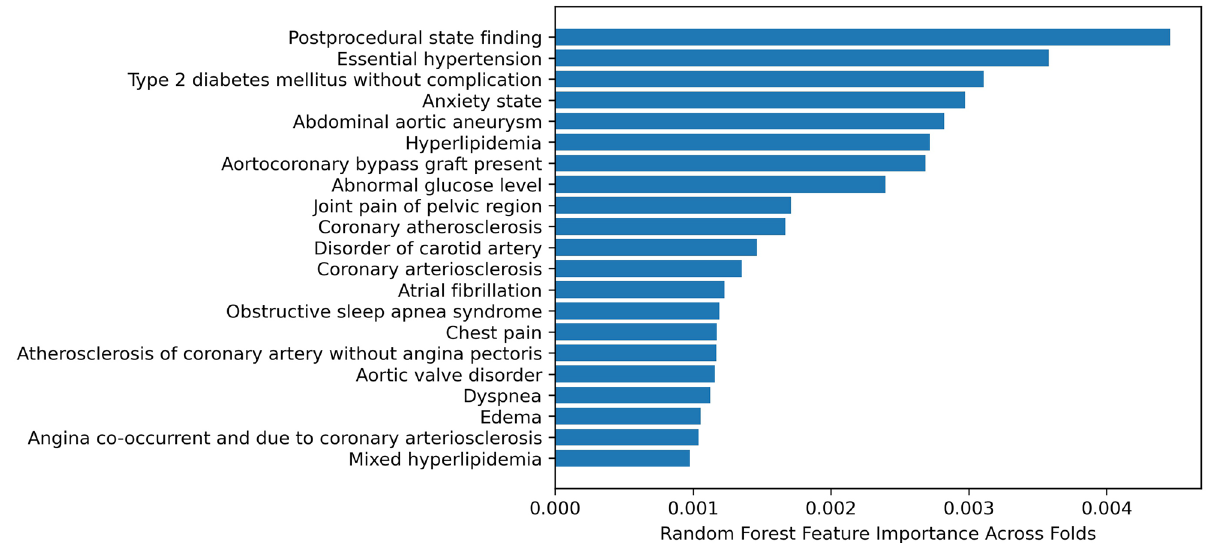
Figure 4. Features most heavily weighted in discriminating between cases and controls in random forest model, based on feature importance averaged across folds.